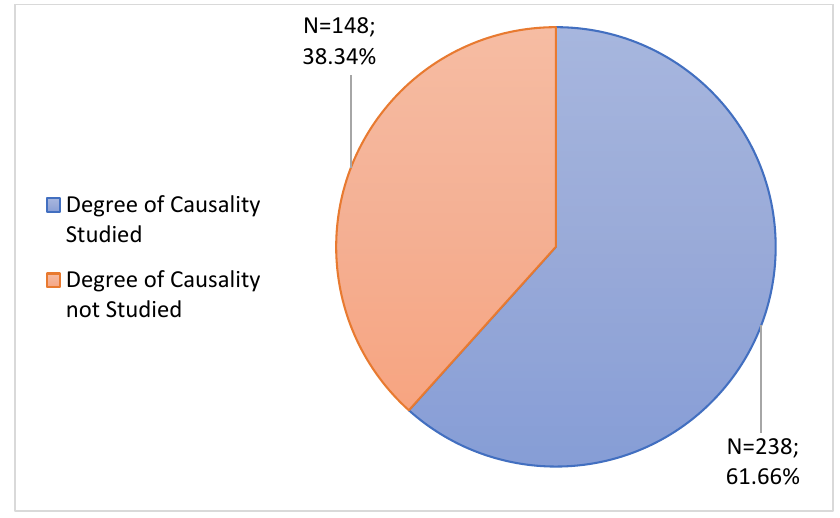
Figure 7. Study of Causality.